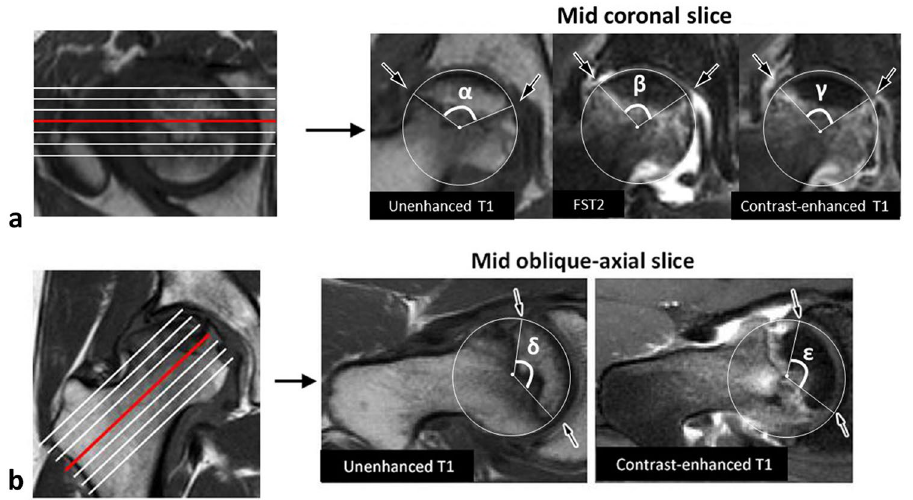
Figure 3. Assessment method for the boundary of the necrotic lesion. ( a ) The medial and lateral boundaries of the necrotic lesion are assessed on both mid coronal unenhanced T1 ( arrows ), fat-saturated (FS) T2 ( arrows ), and contrast-enhanced (CE) T1 images ( arrows ). When the difference with more than 10° between α, β and γ angles is observed, the case is categorized as difference group. In this example, the α, β and γ angles are 118°, 97° and 98°, respectively. Therefore, this case is categorized as difference group in the coronal T1 image and non-difference group in the coronal FST2 image. ( b ) The anterior and posterior boundaries of the necrotic lesion are assessed on both mid oblique-axial unenhanced T1 (arrows ) and CET1 images ( arrows ). When the difference with more than 10° between δ and ε angles is observed, the case is categorized as difference group. In this example, the γ and δ angles are 129° and 115°, respectively. Therefore, this case is categorized as difference group.